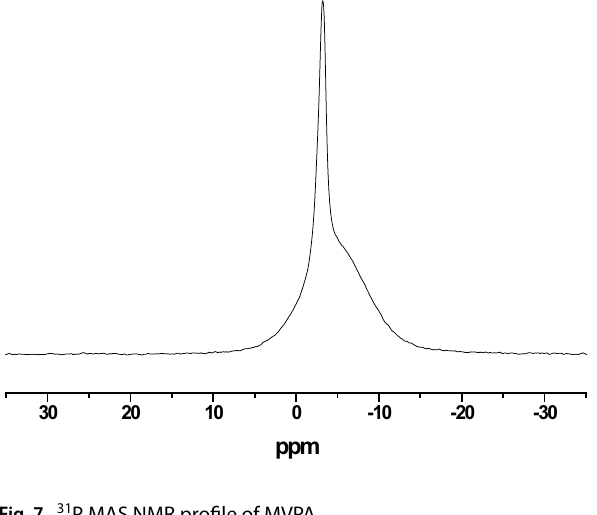
Fig. 7 31 P MAS NMR profile of MVPA